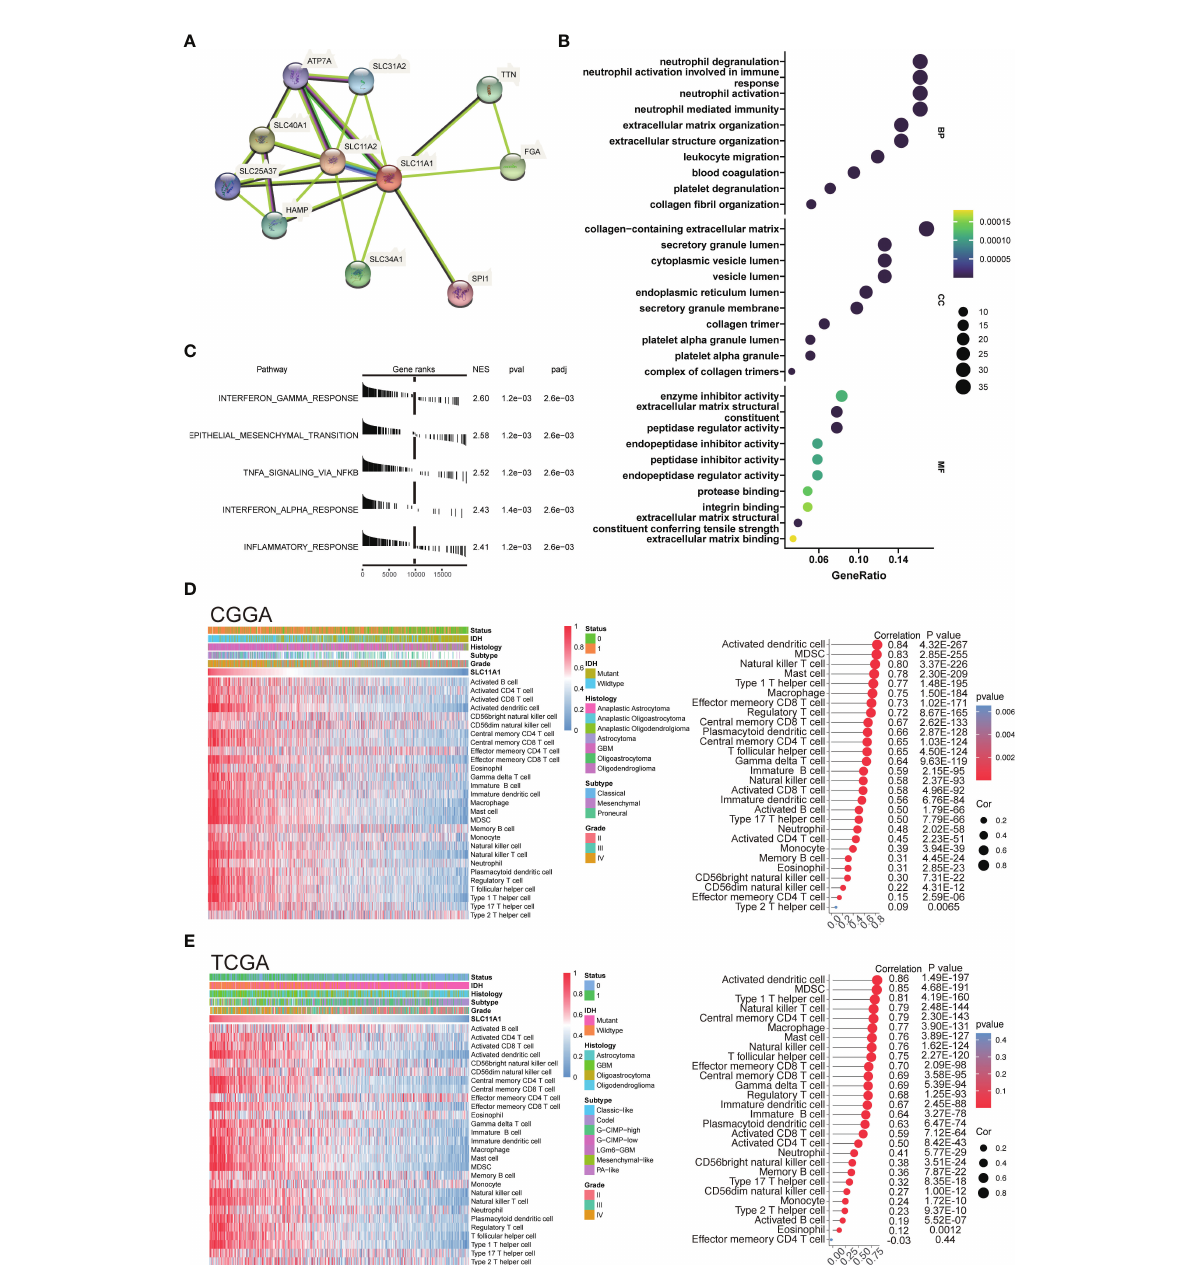
FIGURE 5 SLC11A1 is associated with immune in fi ltration and immune activation in gliomas. (A) STRING database shows the PPI network of SLC11A1. (B) GO (Gene Ontology) results for differential expression genes (Cut-off criteria for DEGs signi fi cance was adj. p value< 0.05 and the absolute value of the log2FC ≥ 1.5). The X-axis represents gene ratio and the Y-axis represents different enriched pathways (BP: biological progress; CC: cellular component; MF: molecular function). (C) Rank-based gene set enrichment analysis shows signi fi cantly activated hallmark pathways in SLC11A1 high subgroup compared with low subgroup. (D) Heatmap showing SLC11A1-associated relative abundance of 28 immune cells in gliomas (CGGA), annotations show corresponding clinical features of each sample. (E) Heatmap showing SLC11A1-associated relative abundance of 28 immune cells in gliomas (TCGA), annotations show corresponding clinical features of each